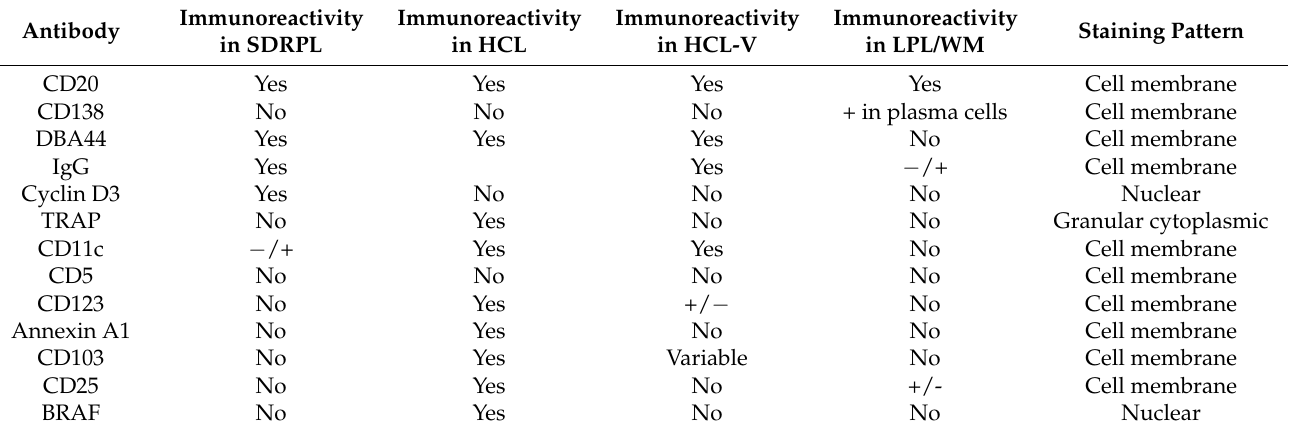
Table 4. Immunostains in SDRPL compared to HCL, HCL-V, and LPL/WM.